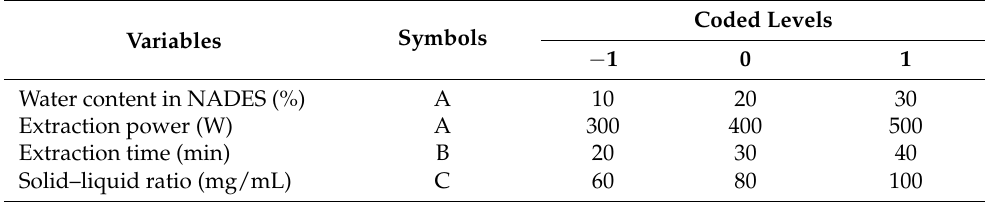
Table A1. Independent variables and levels for Box-Behnken design.